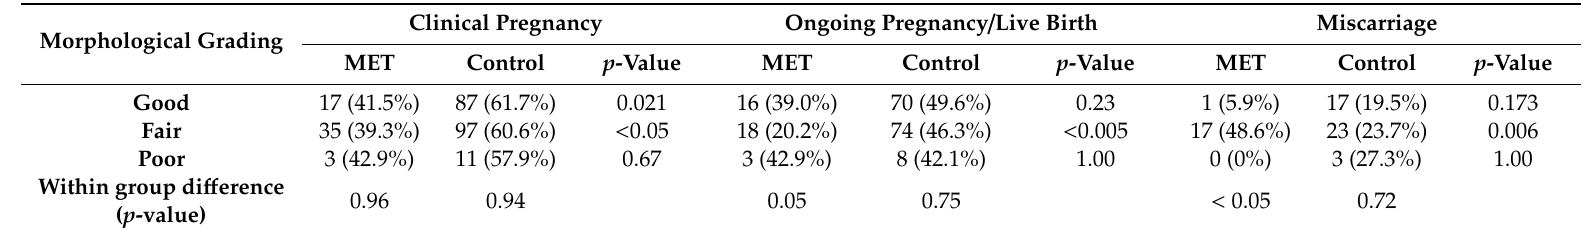
Table 5. Outcome comparison by morphological